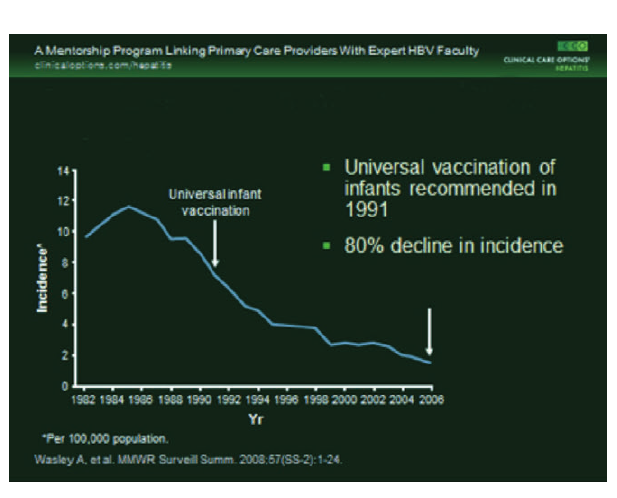
Figure 1. Screen for HBV in individuals born in intermediate/high prevalence locations.